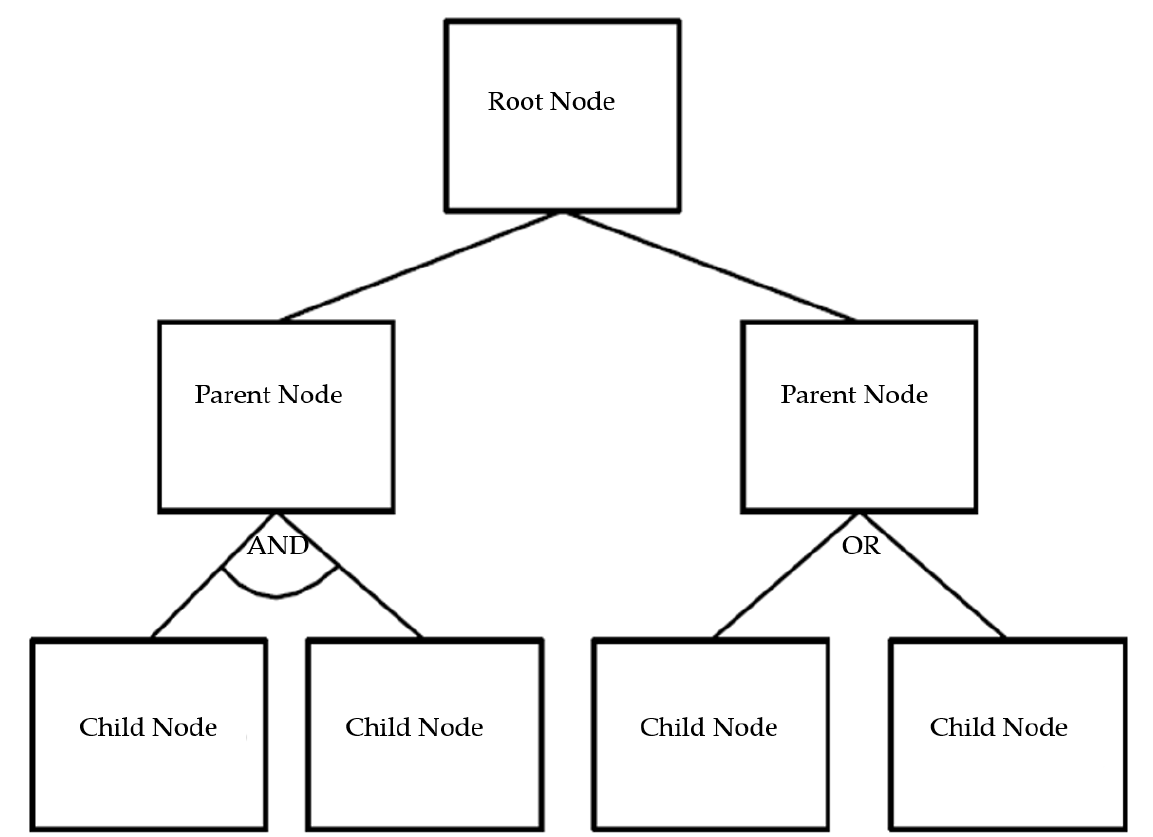
Figure 2. AND and OR relationships between